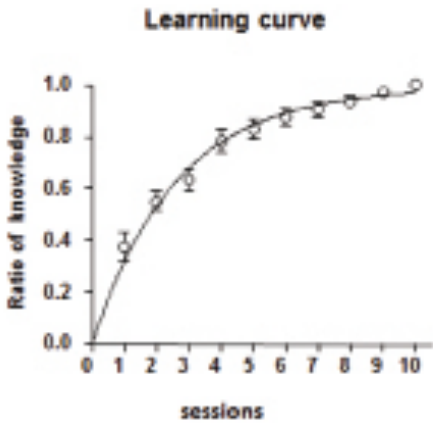
Figure 3 - Learning curve revealing a plateau after the 5th training session on